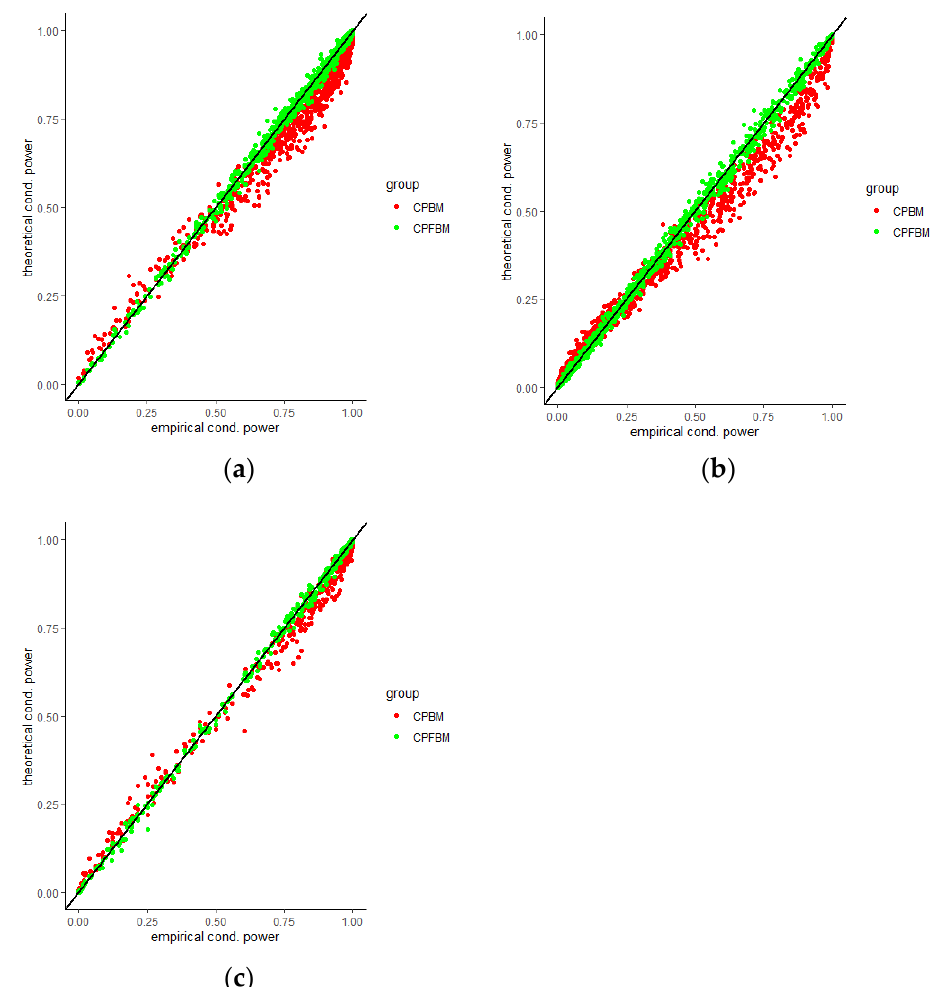
Figure 6. Scatter plots for conditional power under misspecification scenarios (PS design) showing no covariates with different ti.fix time points: ( a ) ti.fix = 0.7; ( b ) ti.fix = 0.8; ( c ) ti.fix = 0.9.